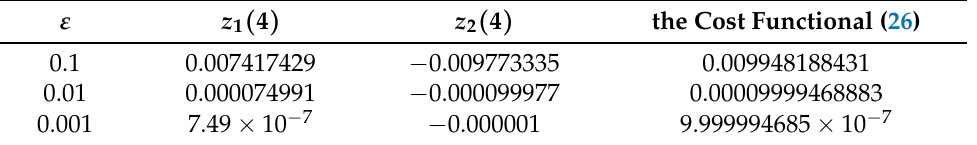
Table 3. Numerical calculations for varying ε